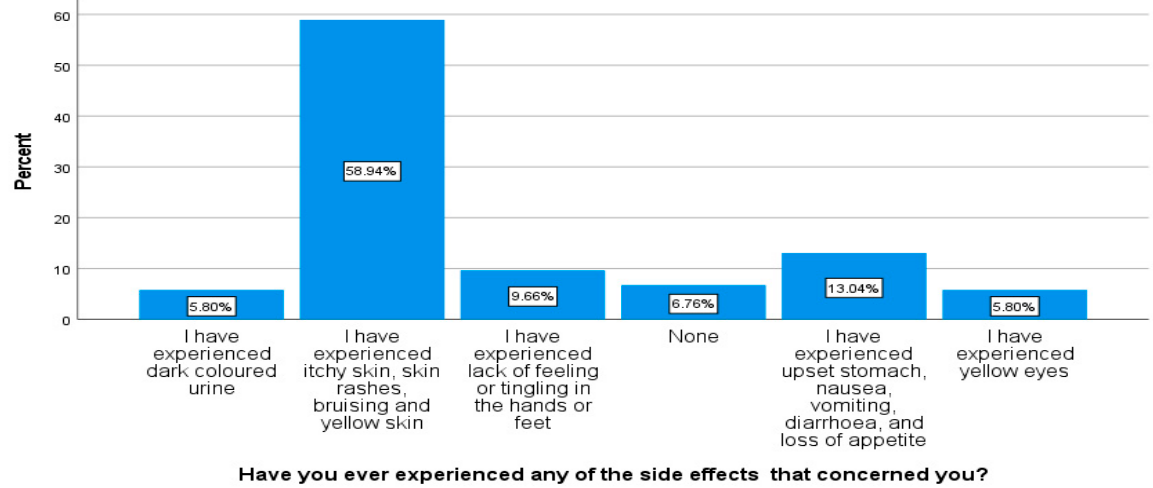
Figure 4. Review of whether respondents had ever experienced any TB treatment side effects ( n = 207).